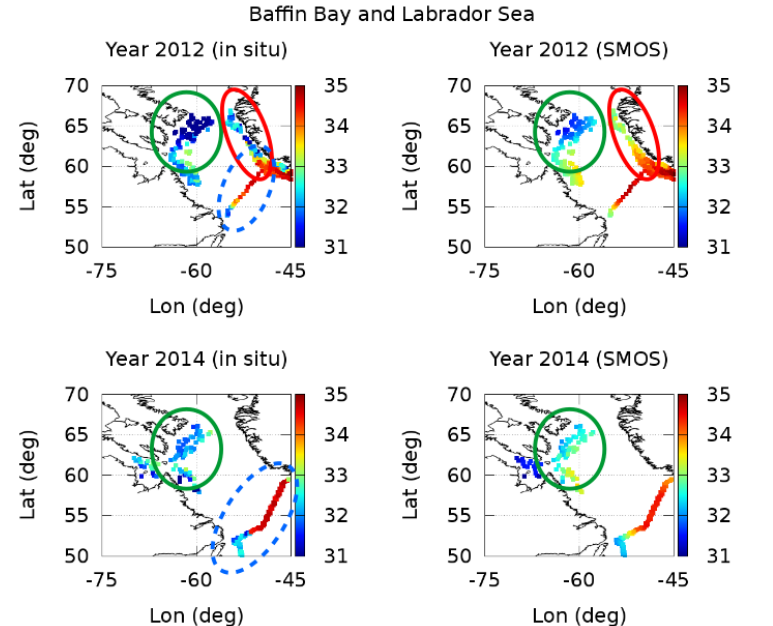
Figure 8. TSG ( left column ) and SMOS ( right column ) SSS in the Baffin Bay and Labrador Sea for 2012 ( top ) and 2014 ( bottom